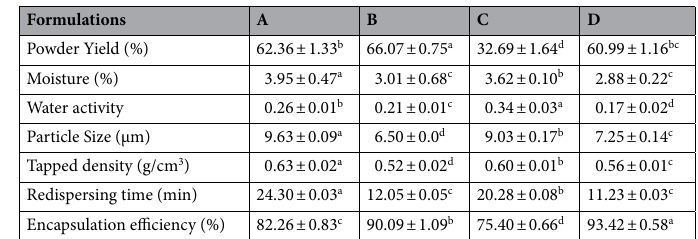
Table 2. Physical properties of yak butter powders. Data represented as mean ± standard deviation. “a,b,c,d” indicate significant differences within yak butter powders at p <